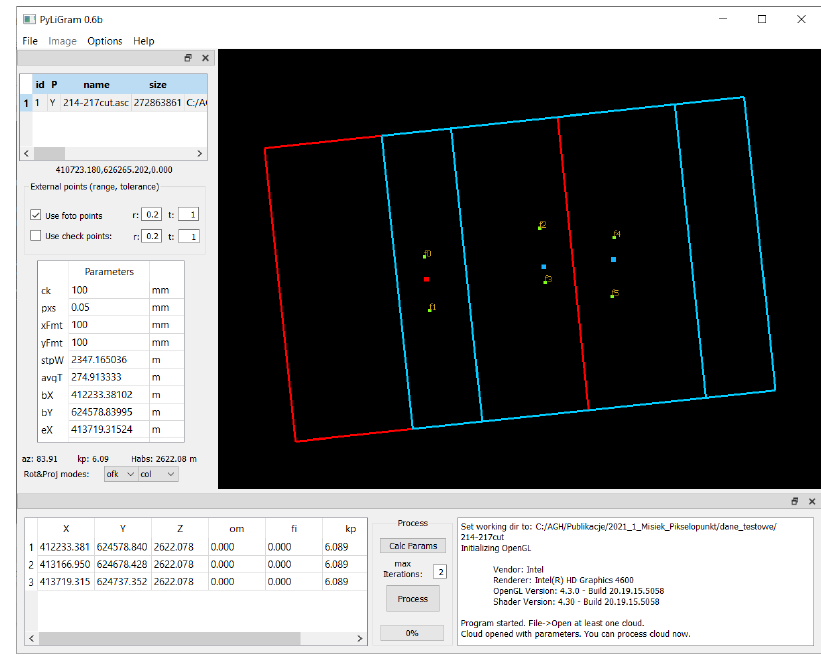
Figure 2. Interface of the PyLiGram research tool with ALS single strip with 6 GCPs (green) and 3 generated lidargramms.